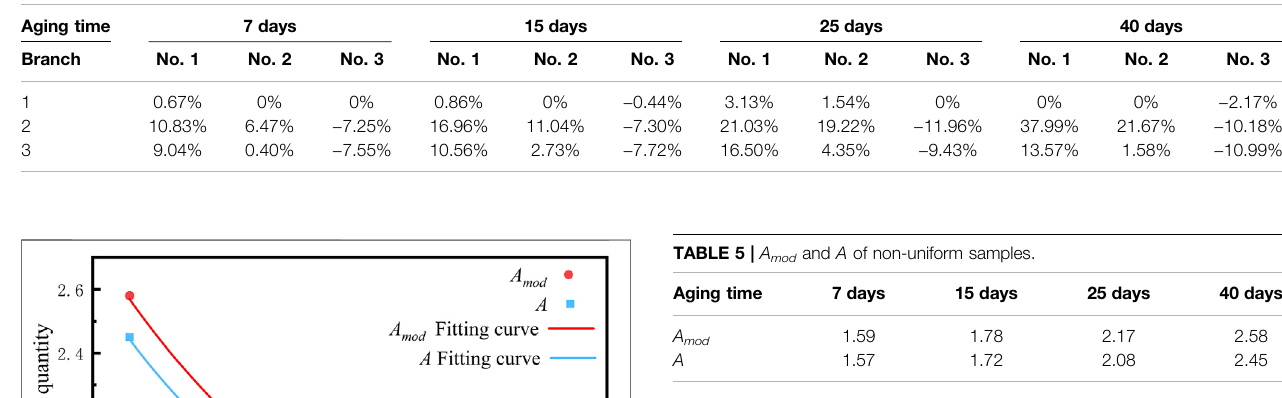
TABLE 4 | Deviation rate of each isothermal area.